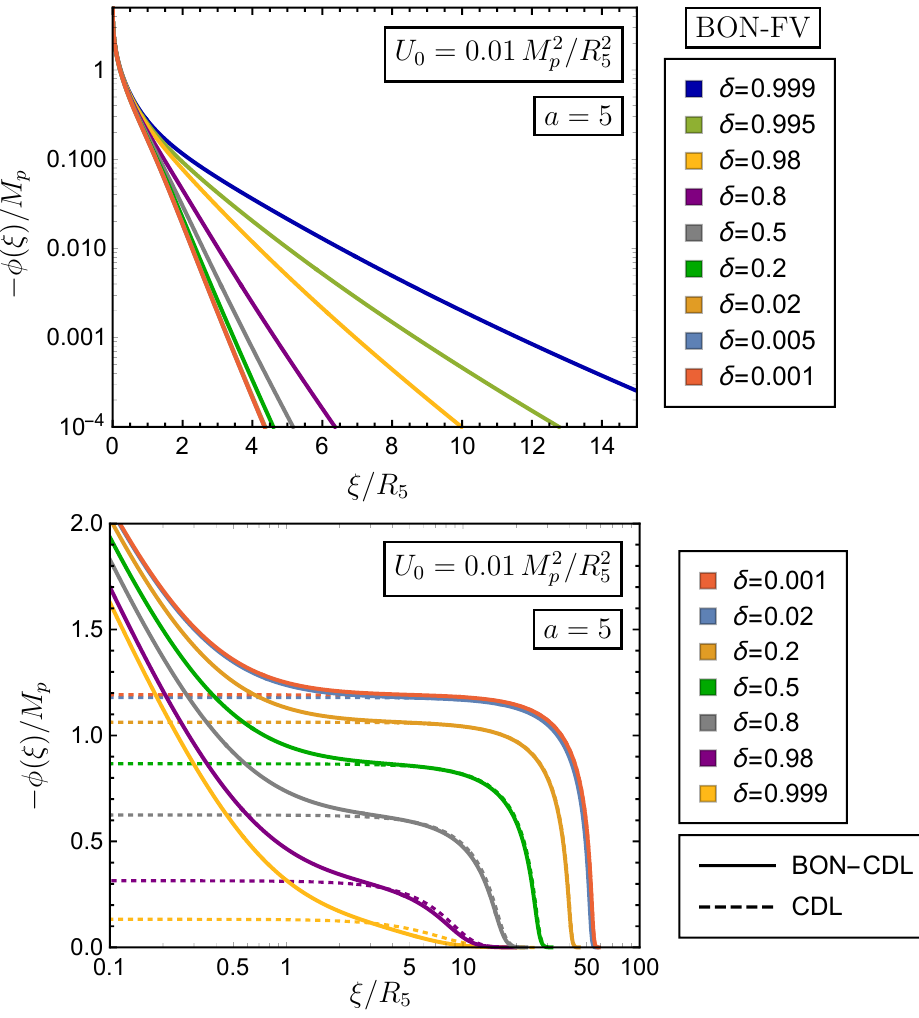
Figure 23: BON-CdL  ( ⇠ ), function of ⇠ /R